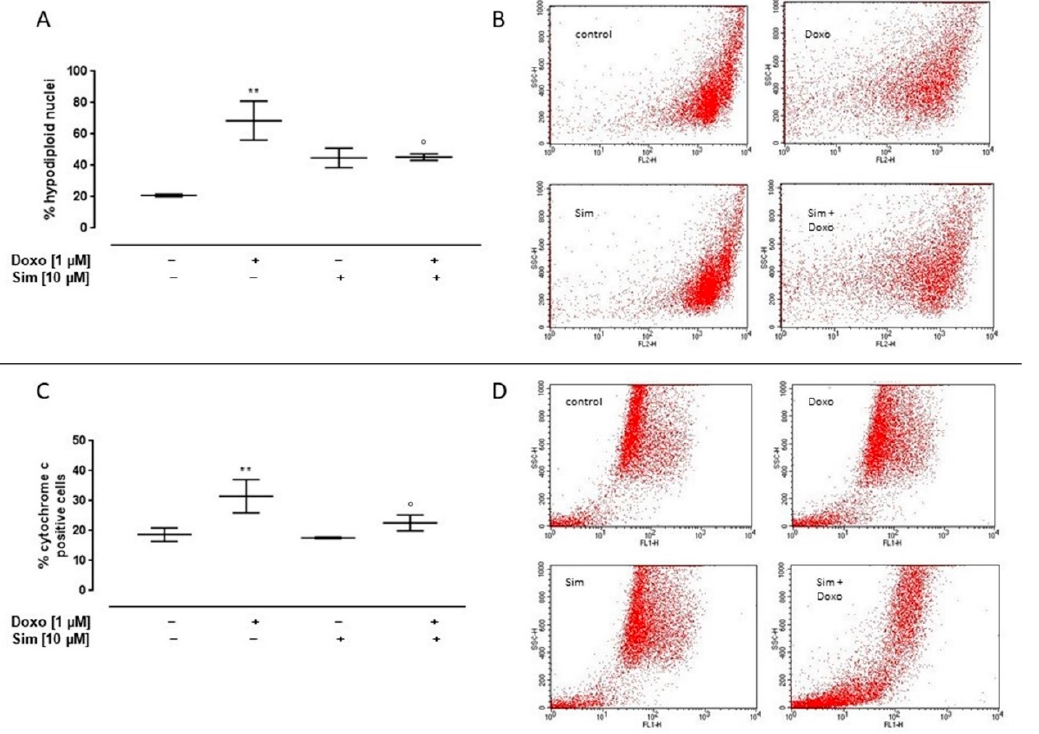
Figure 3. Effect of Simvastatin on Doxorubicin-induced apoptosis. H9c2 cells were pre-treated with Sim (10 µM) for 4 h and then co-exposed to Sim and Doxo (1 µM) for 20 h. Cells were stained by propidium iodide, and fluorescence of individual nuclei was measured by flow cytometry. Results are reported as mean ± S.E.M. of percentage of hypodiploid nuclei from at least three independent experiments, each performed in duplicate ( A ). Flow cytometry analysis was used to evaluate cyto- solic cytochrome c level ( C ). Results are reported as mean ± S.E.M. of cytochrome c-positive cells’ percentage from at least three independent experiments, each performed in duplicate. Representa- tive histograms for the fl ow cytometry analysis are reported in panels ( B , D ), respectively. Data were analyzed by variance test analysis, and multiple comparisons were made by Bonferroni’s test. ** p < 0.005 vs. untreated cells; ° p < 0.05 vs. Doxo-treated cells.